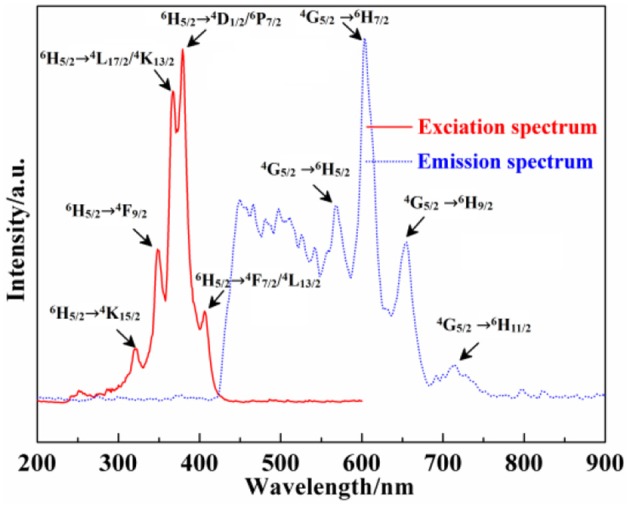
Excitation and emission spectra of Ca12Al14O33: Sm3+.